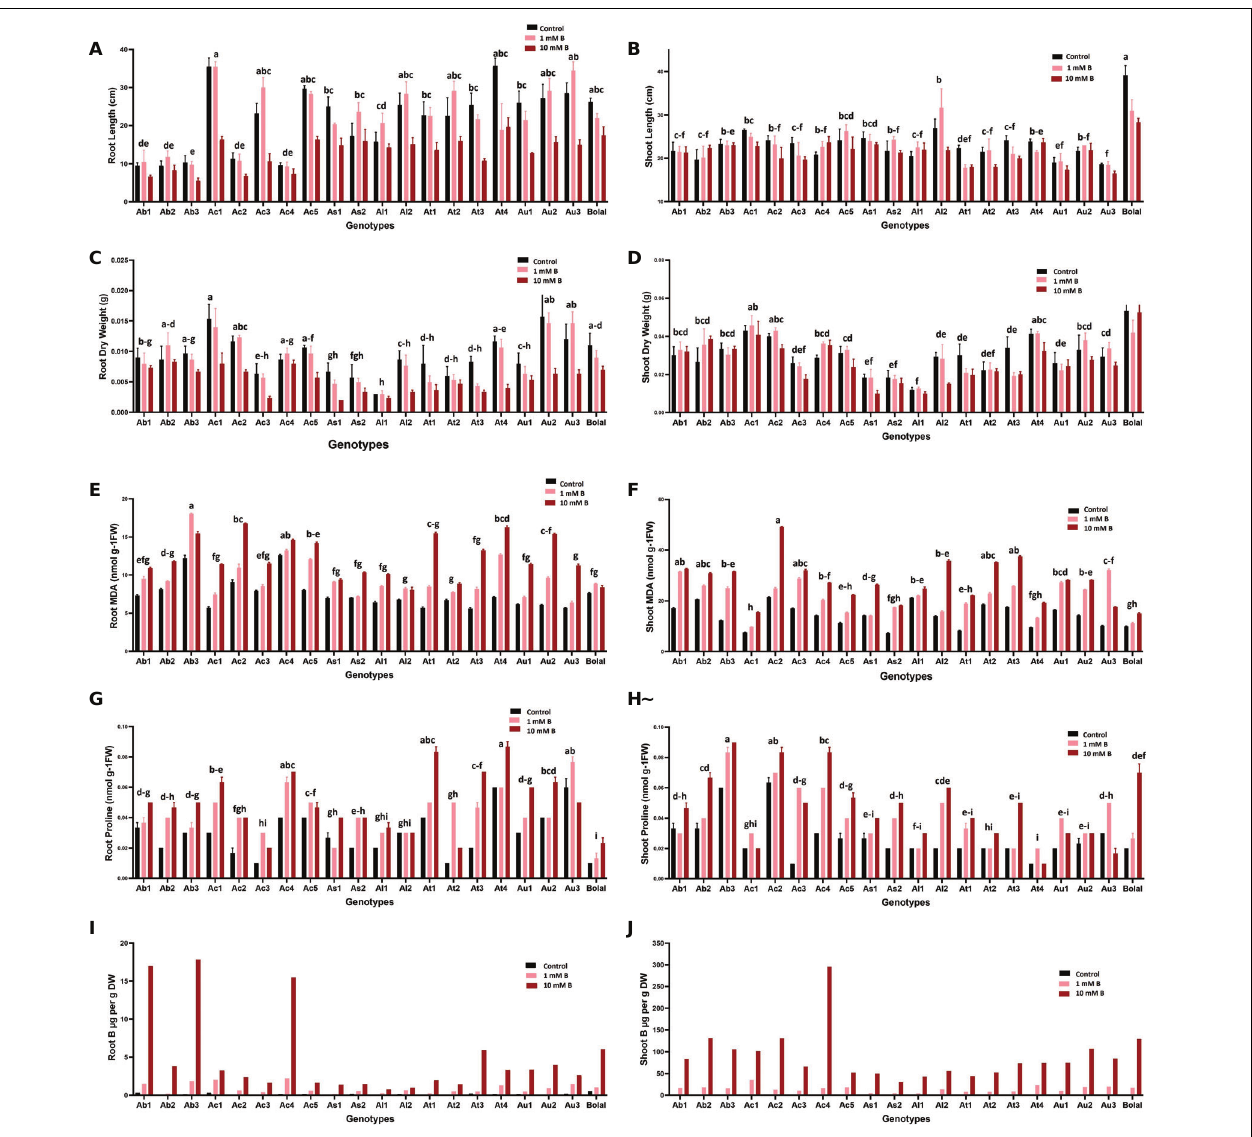
FIGURE 3 | Variability in the (A) RL (B) SL (C) RDW (D) SDW (E) RMDA (F) SMDA (G) RProline (H) SProline (I) RB accumulation and (J) SB accumulation of 19 Aegilops accessions and the B-tolerant check cultivar, Bolal 2973 grown under Control (3.1 µ M B), toxic B (1 mM B), and highly toxic B (10 mM B). Data represent means ± SE. Tukey’s pairwise comparison using the general linear model was employed to distinguish any significant differences among the experimental genotypes. Genotypes that do not share a letter are significantly different.